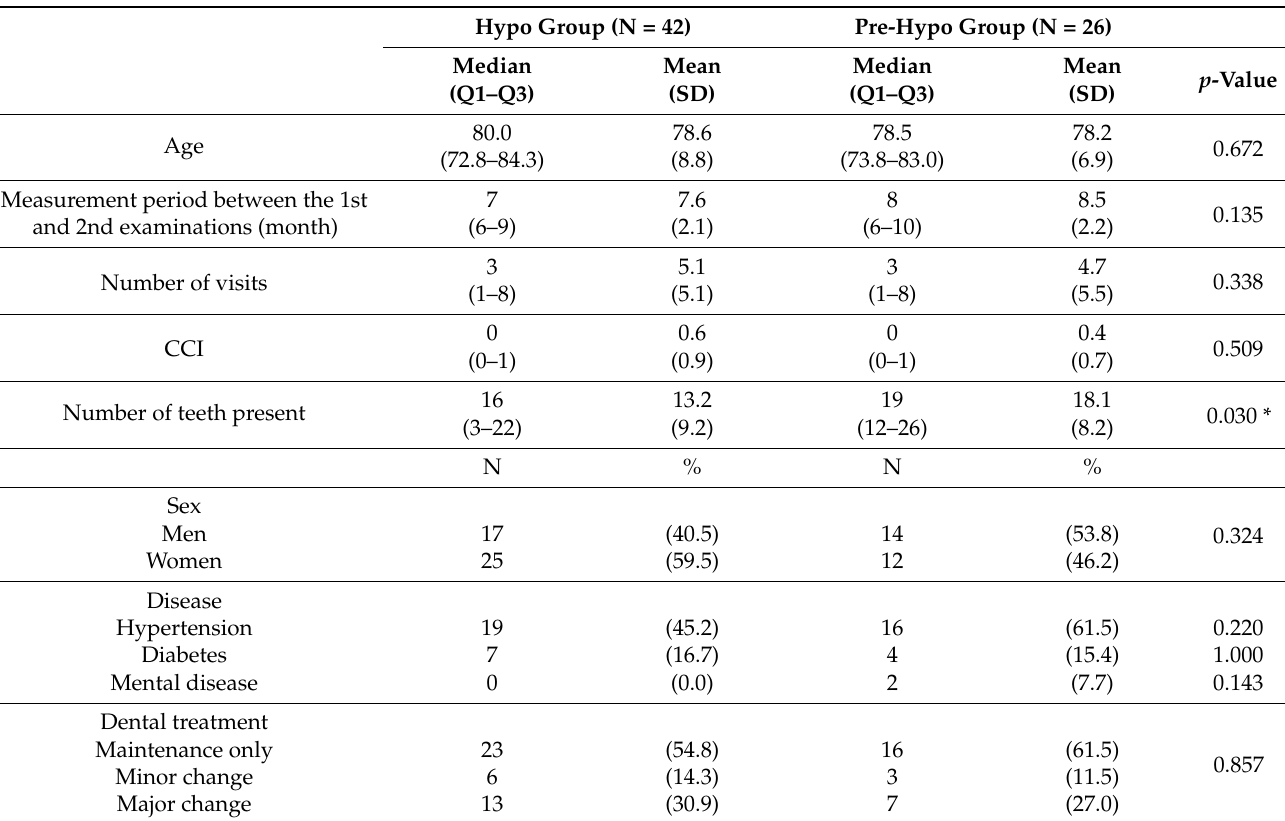
Table 1. Participants